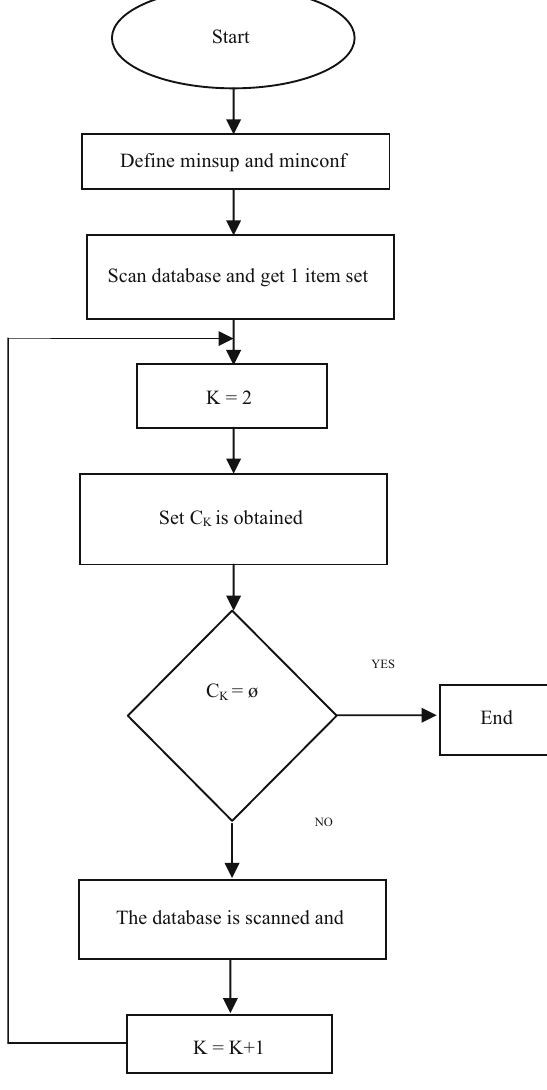
Figure 4: Flow chart of the Apriori